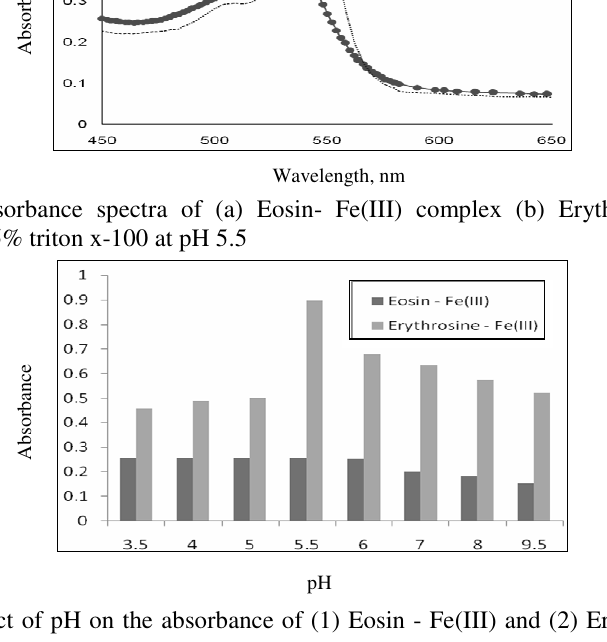
Figure 2. Effect of pH on the absorbance of (1) Eosin - Fe(III) and (2) Erythrosine Fe(III) complex